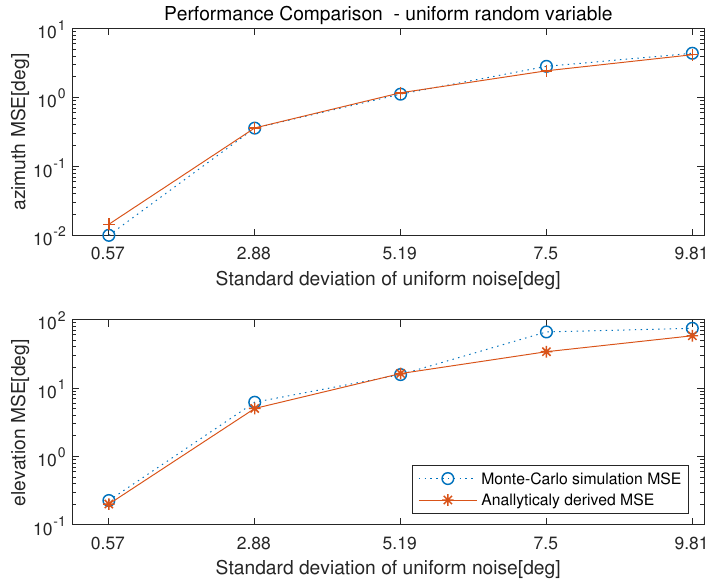
Figure 5. Performance for uniformly − distributed phase measurement error with θ ( 0 ) = 120 ◦ and ψ ( 0 ) = 15 ◦ . This figure shows the MSEs of azimuth and elevation with respect to phase error at a signal with low incident elevation(uniform circular array). It can be confirmed that the MSE of elevation is larger than that of the azimuth at low elevation(uniform circular